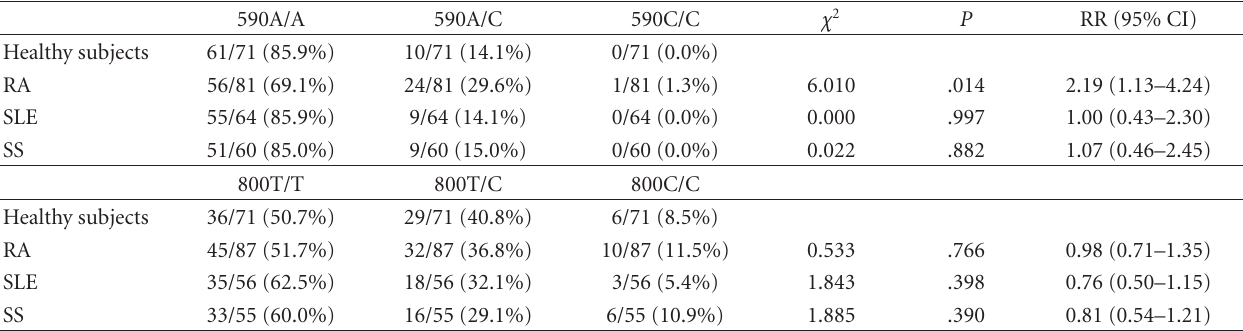
Table 2: Association of 590A/C and 800T/C SNPs of human BTLA gene with susceptibility to autoimmune diseases.